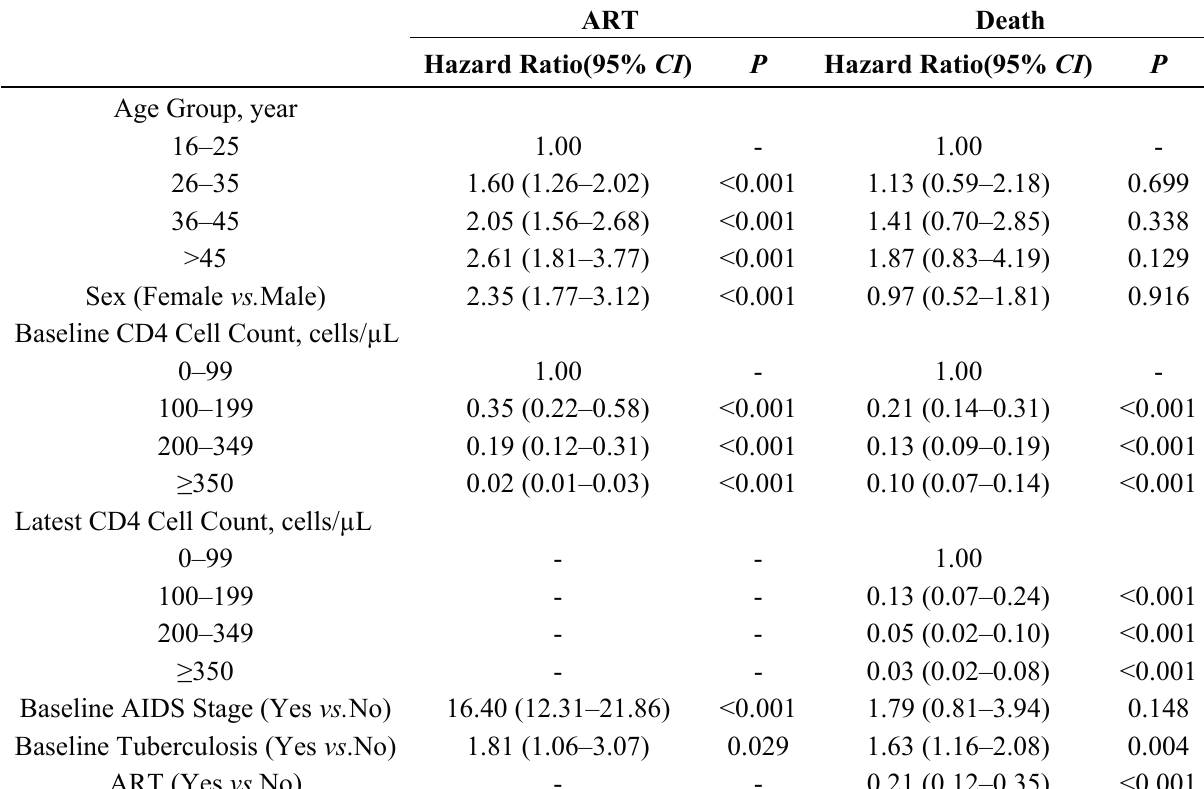
Table 2. Factors Associated With Starting ART or Death.